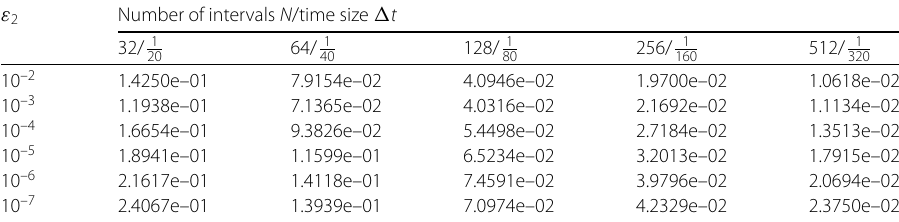
Table 1 Maximum error E N , M ε for Example 5.1 using the adaptive grid method with ε 1 = 10 –2 1 , ε 2